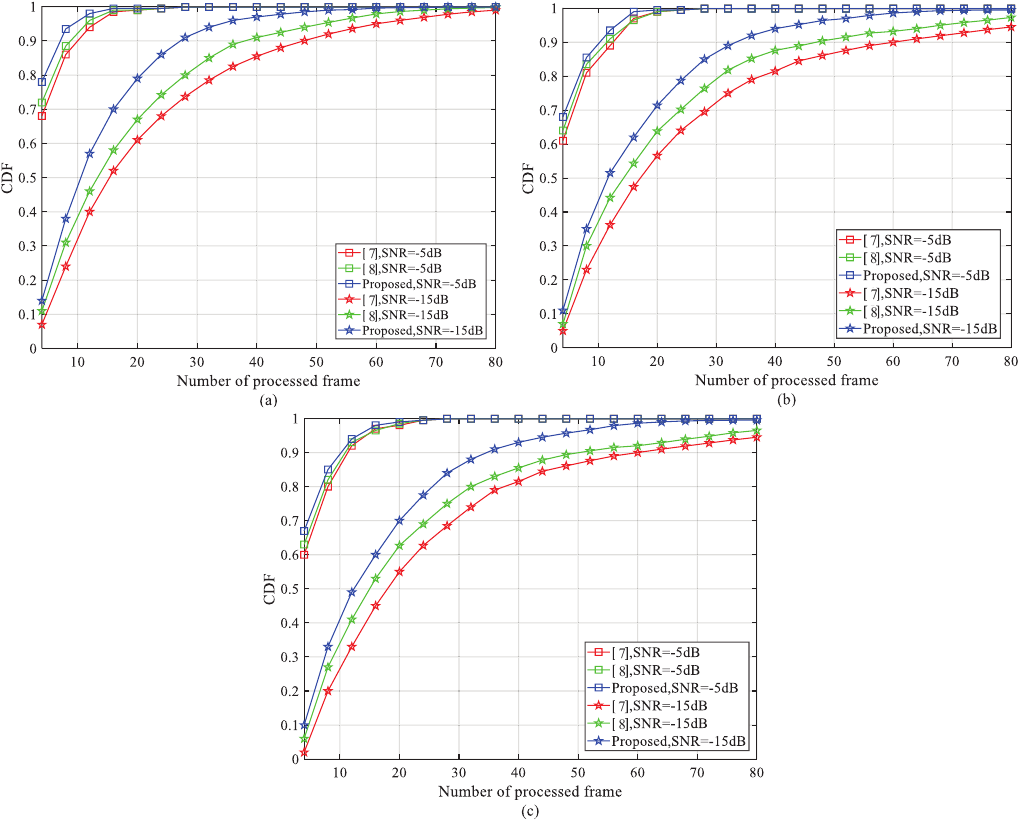
Figure 10. Comparison of cumulative distribution function (CDF) for NPSS detection vs. the number of processed frames under normal coverage and extended coverage: ( a ) AWGN; ( b ) ETU-1Hz; ( c )